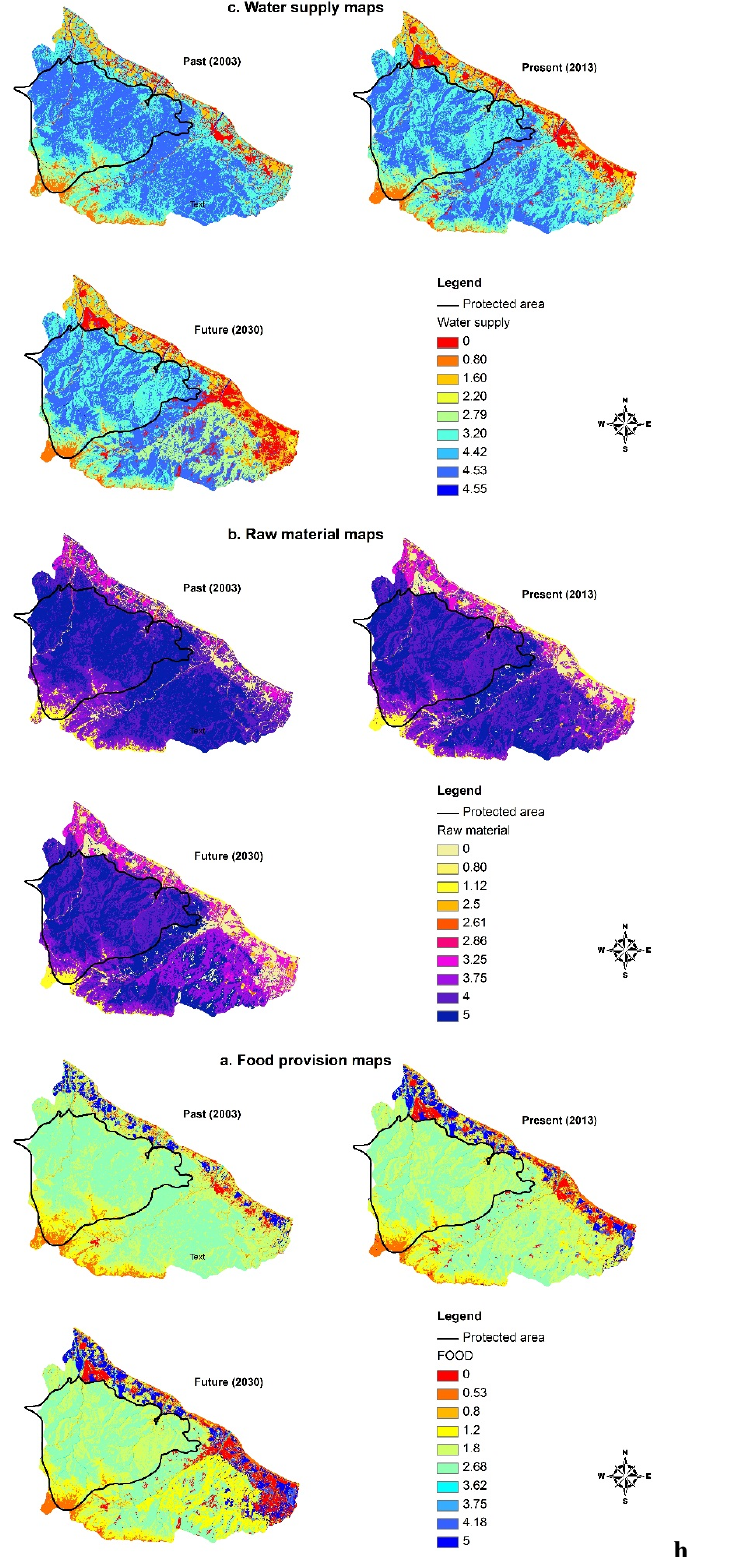
Figure 5. Maps of current, potential, and plausible future supply of ES based on individual service values associated with LULC types and land transformation. Services values are weighted between 0 and 5 based on expert judgment. Services include ( a ) food provision, ( b ) raw materials, ( c ) water supply, ( d ) climate regulation, ( e ) soil conservation, ( f ) recreation, ( g ) biodiversity, and ( h ) water